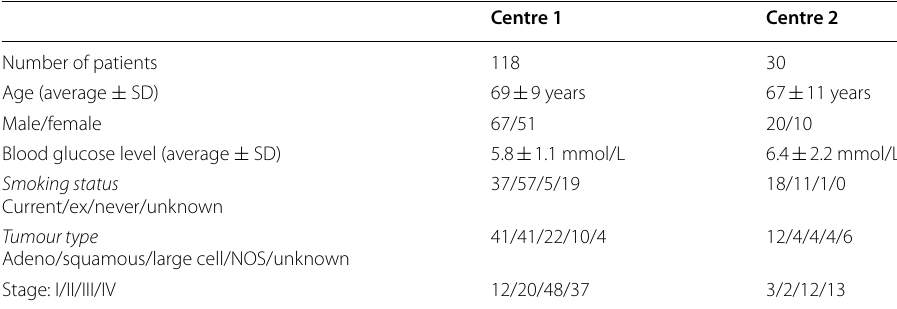
Table 1 Patient